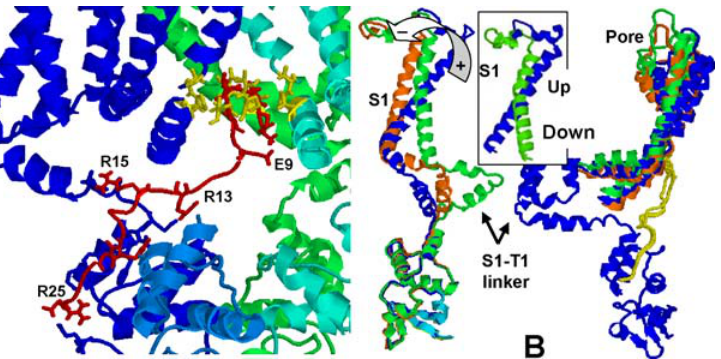
Figure 3. Ball and spring bi-valent complex model of inactivating N-terminal peptide (red) and Shaker Kv1.2 [ 3 ] . (A) Shaker includes the S1-T1 (G131-S159) domain modeled here, but has almost no bearing in the complex structure. For clarity, we removed the TM and linker domains of the cyan monomer, Y132-T421. The interaction [21] between the ball (M1-E9) and the pore is dominated by hydrophobic contacts involving residues I5, V3, C7 and M1, and the Valine ring in the pore V406, V410, and P407 (in yellow). On the other hand, the hydrophilic tail binds mostly due to Hydrogen bonds between peptide residues R15, R25, R20, R13 and L21, and T1 domain residues E136, E121, E56, D129, D107 (cyan monomer), E130, M125 and F126, respectively. Chemical affinity (electrostatic plus desolvation) of the ball and tail in the bound state is estimated to be 2 12 and 2 41 kcal/mol, respectively [21]. (B) Structural transition upon repolarization modeled using essential dynamics (see Methods). For clarity, only one of the four symmetric monomers is shown: Kv1.2 crystal structure (blue) as in Fig. 3A, repolarized (red) and hyperpolarized (green) models. Arrow indicates direction of S1 rotation due to repolarization. For comparison, inset shows the equivalent view of the S1 helix from the crystal and the ‘‘down’’ model of Yarov-Yarovoy et al. [16]. Also shown are the bound peptides (in yellow) for the crystal and hyperpolarized model structure.